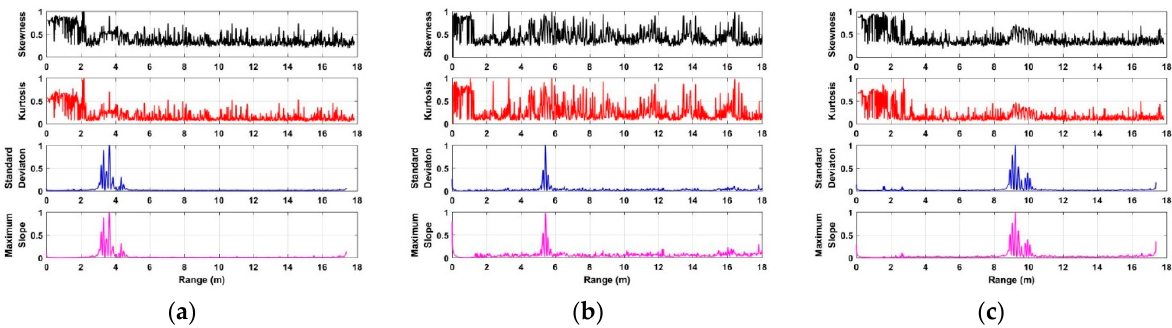
Figure 12. The distance estimates based on the acquired data from a human being at distances of ( a ) 3 m; ( b ) 6 m; and ( c ) 9 m outdoors.